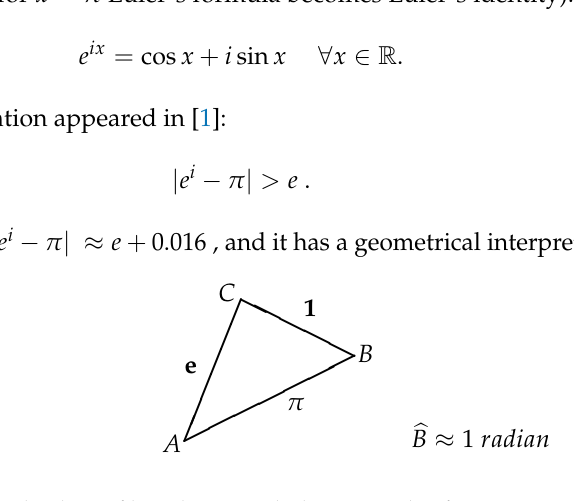
Figure 1. A triangle with edges of length 1, π and e has an angle of approximately 1